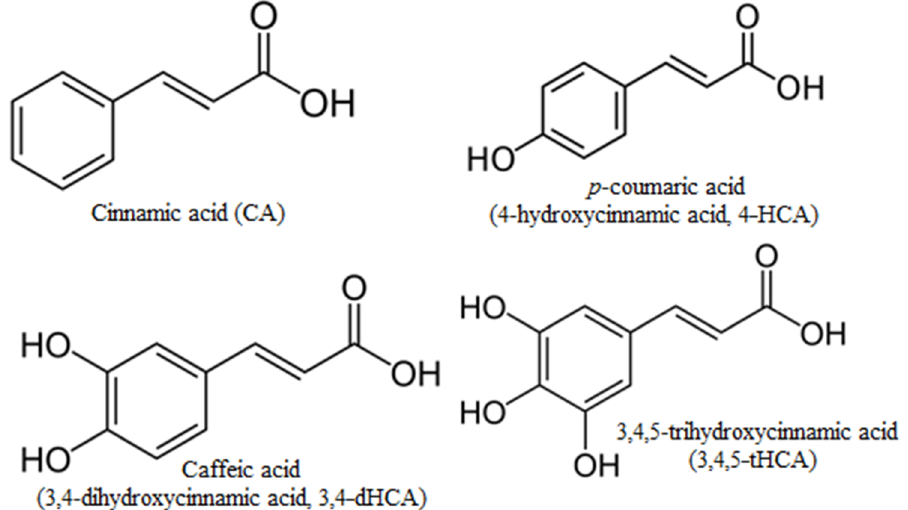
Figure 1. Structures of cinnamic acid and its hydroxyl derivatives.